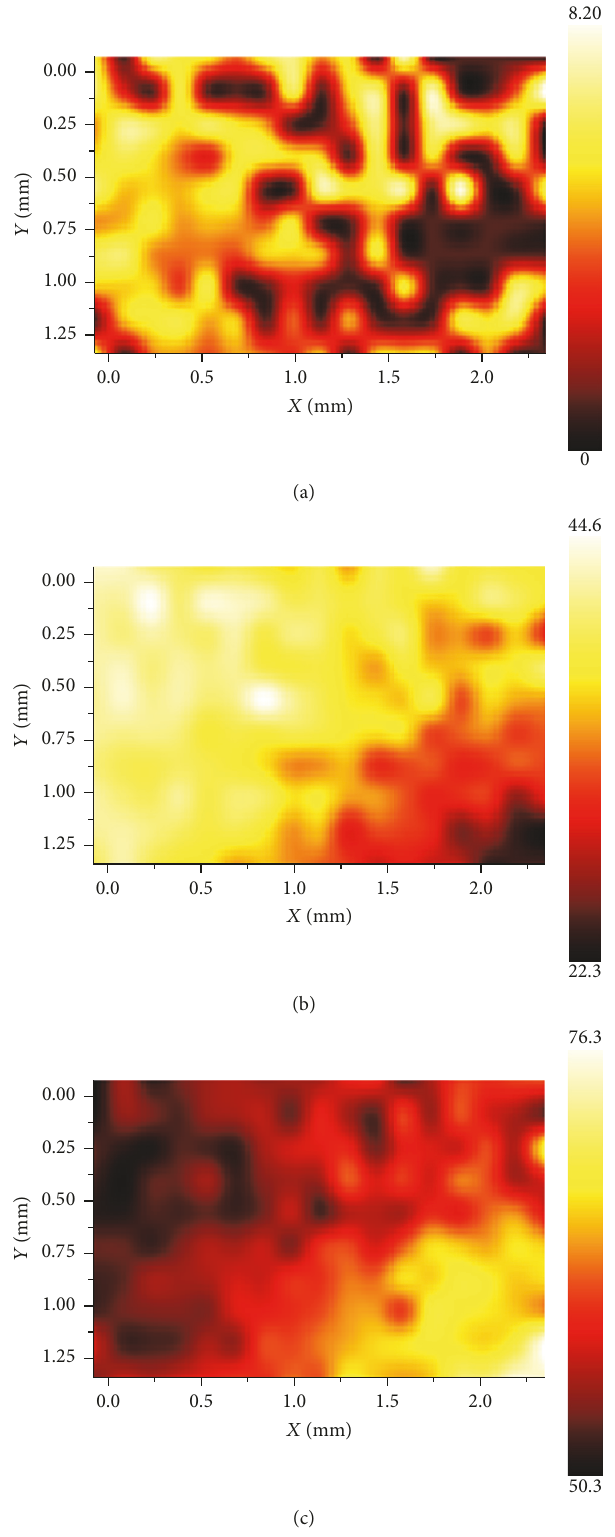
Figure 14: XPS maps for the atomic percentages of (a) Al2p; (b) O1s; and (c) Mg1s for the AZ91D alloy immersed for 30 minutes in 3.5 wt.% NaCl solution at room